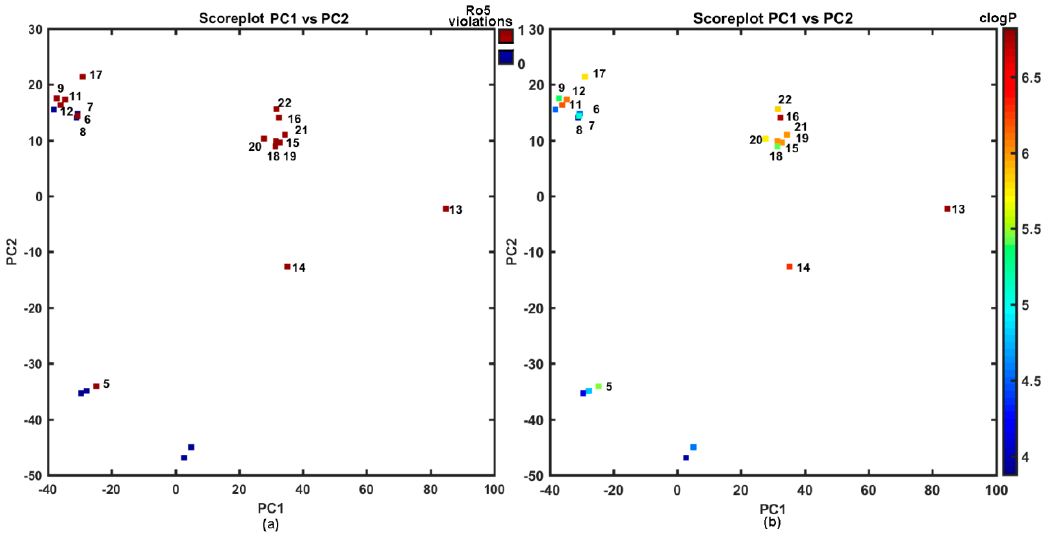
Figure 1. Projection of carboxamides 1 – 22 on plane defined by first vs. second principal components for Dragon descriptors ( a ) with MRSA activity in logarithmic scale ( b ) colors code numerical values of pMRSA activity. Molecules with pMRSA > 4 are numerically labeled.